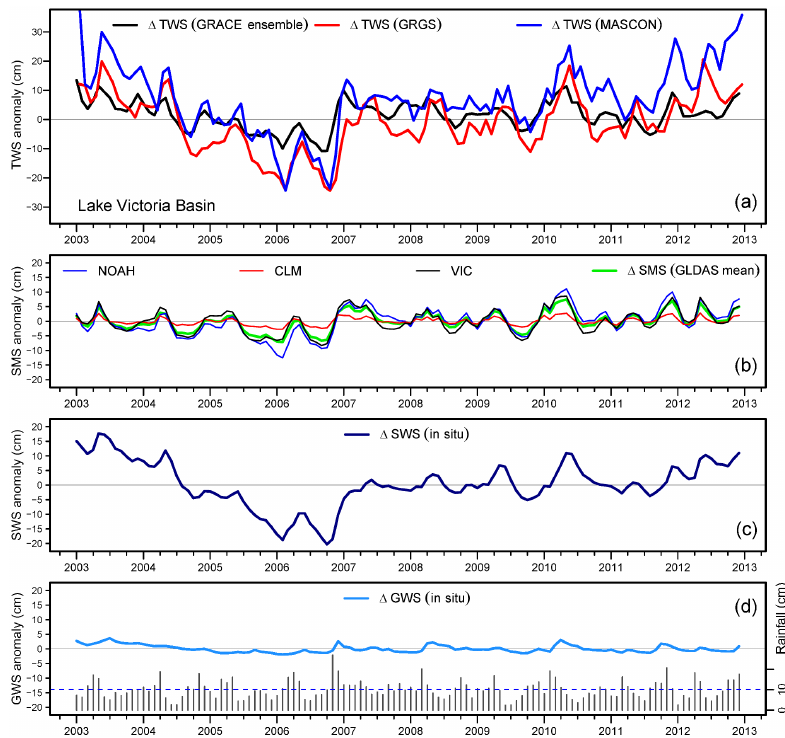
Figure 5. Monthly time-series datasets for the LVB from January 2003 to December 2012: (a) GRCTellus GRACE-derived (cid:49) TWS (ensemble mean of CSR, GFZ, and JPL), GRGS and JPL-Mascons (cid:49) TWS time-series data; (b) GLDAS-derived (cid:49) SMS (individual signals as well as an ensemble mean of NOAH, CLM, and VIC); (c) lake-level-derived (cid:49) SWS; and (d) borehole-derived (cid:49) GWS time-series data. Note that monthly rainfall records derived from TRMM satellite are plotted on panel (d) where the dashed horizontal line represents the mean monthly rainfall for the period of January 2003 to December